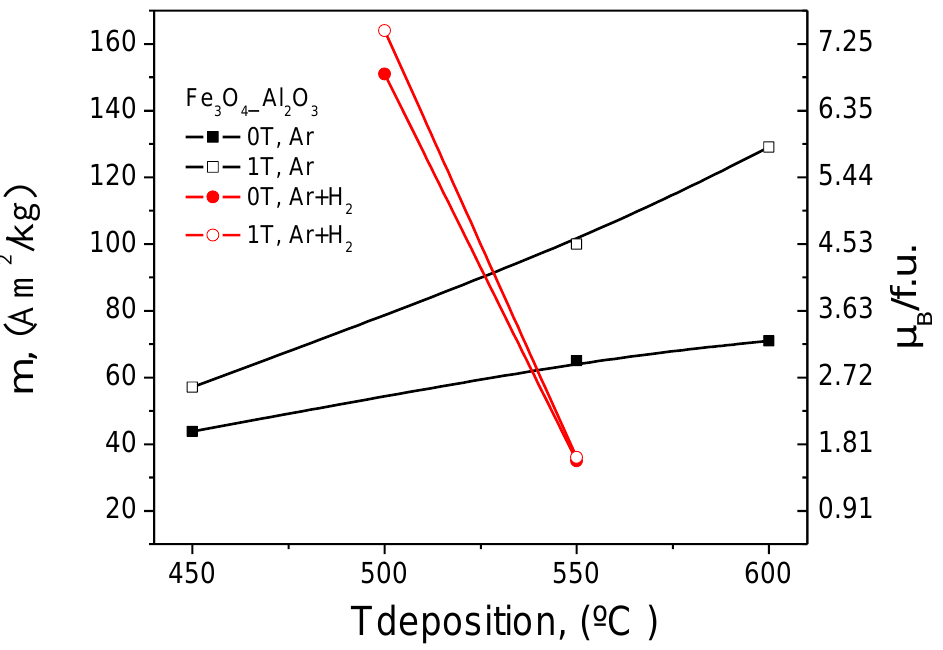
Figure 8. Graphical representation of the M S and µ B /f.u. values versus deposition temperature for the films on Al 2 O 3 grown in and without external magnetic field.